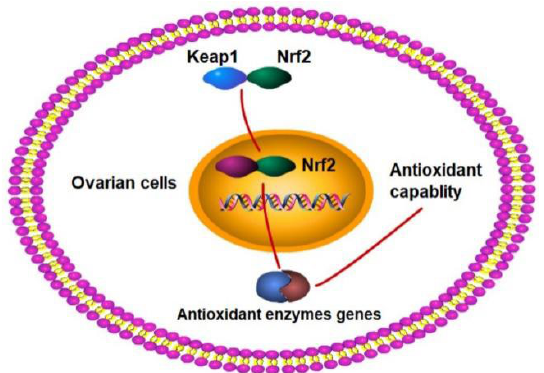
Figure 5. Proposed mechanism of arginine enhancing the ovarian antioxidant capacity during luteal phase in ewes. Nrf2, nuclear factor erythroid 2-related factor 2; Keap1, Kelch-like ECH-associated protein 1.